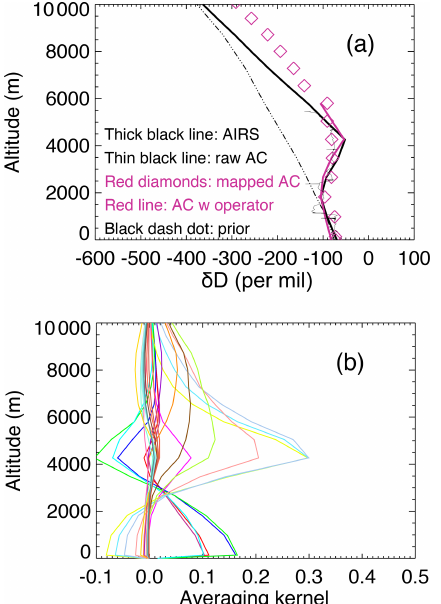
Figure 3. (a) Sample comparison of the δ D profiles by aircraft and satellite over the southeastern Atlantic Ocean during ORACLES on 31 August 2016: shown are AIRS δ D (thick black line), the prior δ D (dashed–dotted black line), nearest WISPER δ D (thin black line), WISPER δ D interpolated or extrapolated to satellite levels (red di- amonds), and the WISPER δ D with the AIRS operator (averaging kernel) applied (thick red line). (b) Averaging kernel corresponding to same AIRS profile on 31 August 2016, color-coded by pressure level. Averaging kernels with the largest positive sensitivity below 2000m are from the lowest